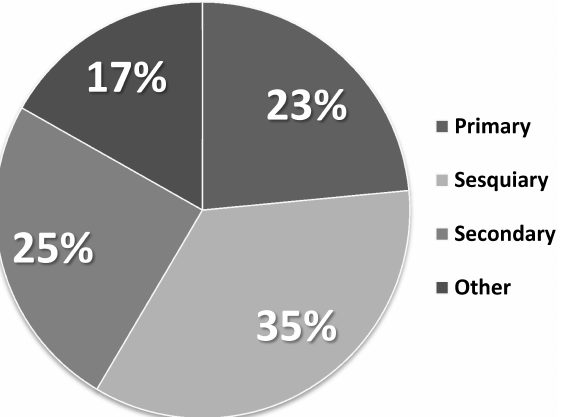
Figure 5. A breakdown of classification of the additional Earthquake tweets according to the rede- fined criteria.